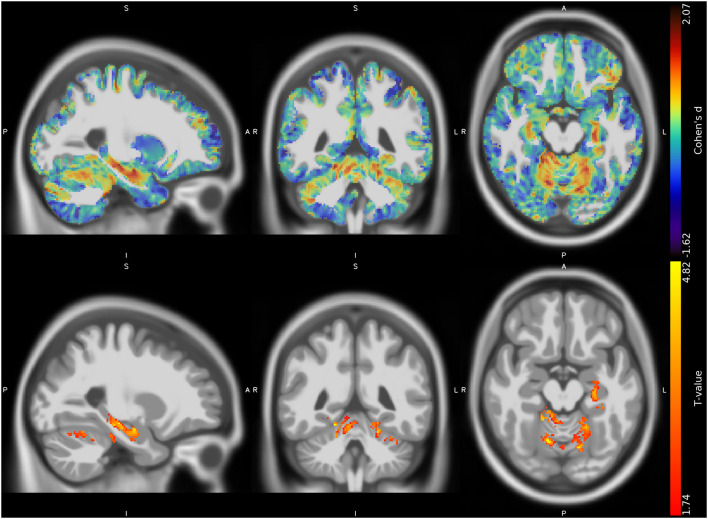
Unthresholded effect size (Cohen's d) map (upper row, in blue-red) and thresholded T map (lower row, in red-yellow) for the CMT > HC contrast regarding the voxel-based between-group comparison of GM maps, superimposed on the T1-weighted template in the sagittal, coronal, and axial planes (from left to right). CMT, Charcot-Marie-Tooth; HC, Healthy Controls; GM, Gray Matter.